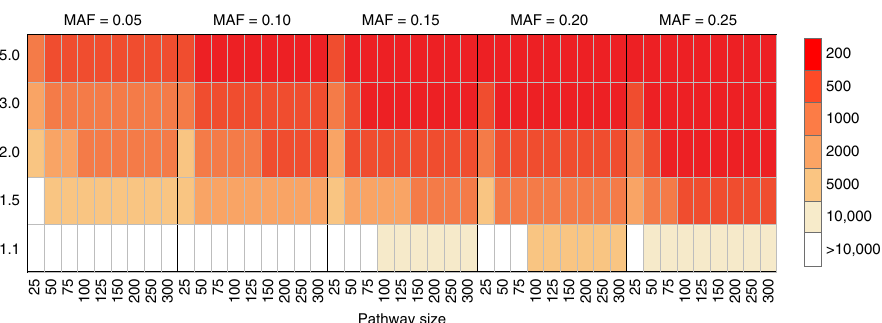
Fig. 6 Simulation-based power analysis. Power analysis of the effect of minor allele frequency (MAF), BPM size, interaction effect size, and sample size on the discovery of between-pathway interactions. Colors in the heatmap indicate the estimated minimum number of samples needed for discovering signi fi cant BPMs of different sizes under each scenarios (MAF at 0.05, 0.1, 0.15, 0.2, 0.25; interaction effects at 1.1, 1.5, 2.0, 3.0, 5.0; BPM sizes at 25 × 25, 50 × 50, 75 × 75, 100 × 100, 125 × 125, 150 × 150, 200 × 200, 250 × 250, 300 × 300). All power analyses were conducted using a signi fi cance